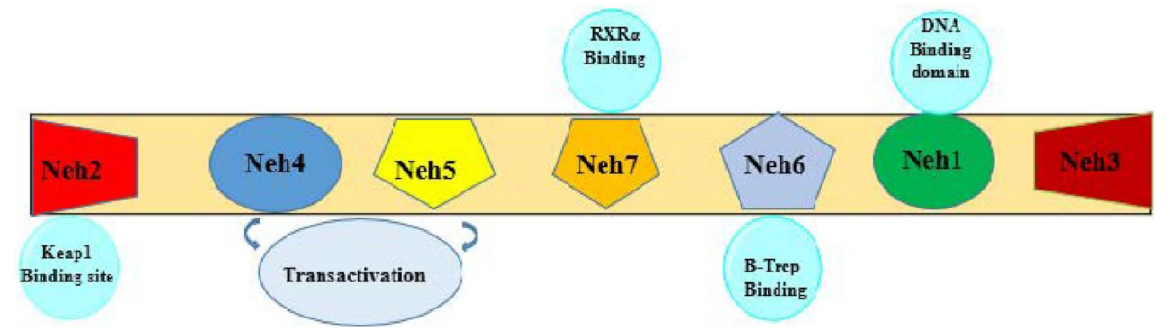
Figure 1. Conserved domains of